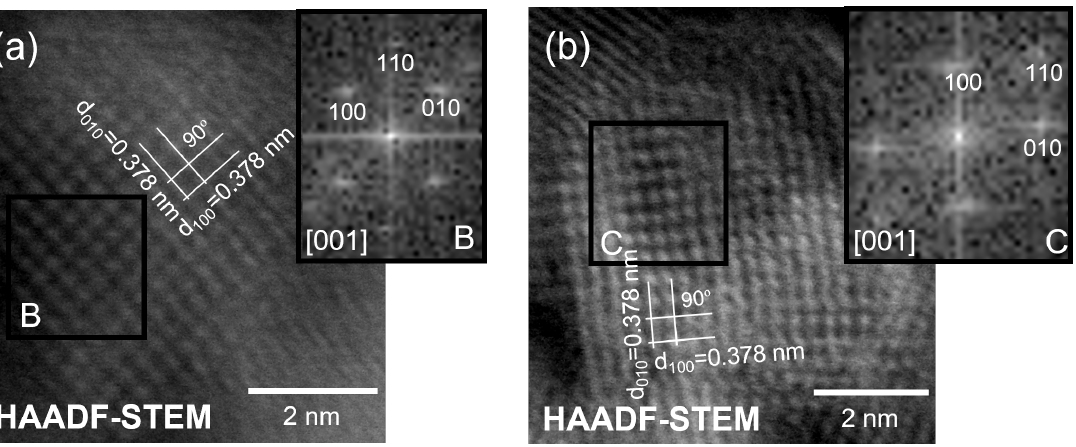
Figure 5. ( a , b ) Atomic-resolution HAADF-STEM images of two distinct TiO 2 nanocrystals. The in- sets in ( a , b ) show the FFT images of areas indicated as B and C, respectively (black squares).